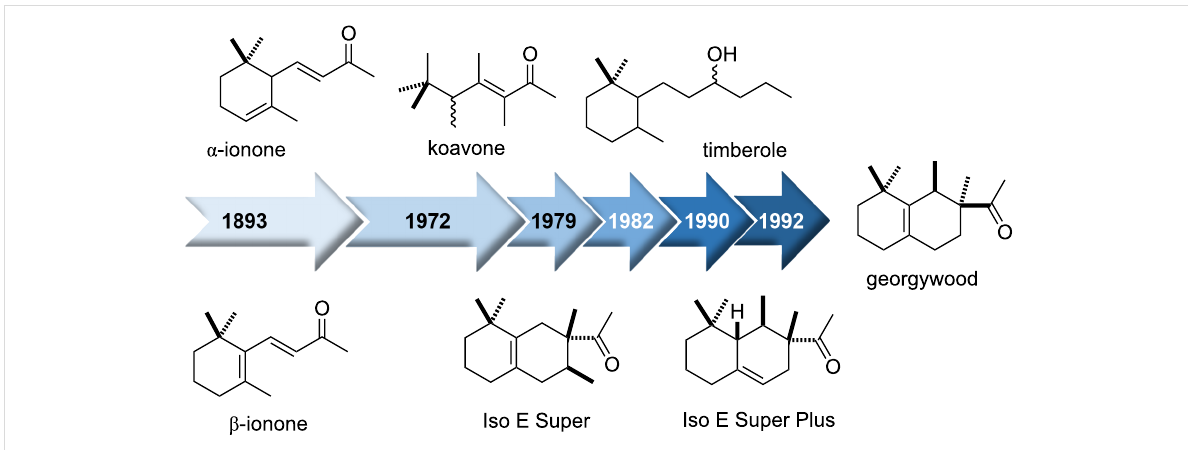
Figure 5: (Adapted from ref. [8]) Ionone ( 30 , 1893, odour threshold: 0.8 ng L − 1 ), koavone (1982, odour threshold: 75 ng L − 1 ), Iso E Super ® ( 33 ) (1972, odour threshold: 500 ng L − 1 ), timberole (1982, odour threshold: 26 ng L − 1 ) Iso E Super Plus ® ( 34 ) (1990, odour threshold: 5 pg L − 1 ) and